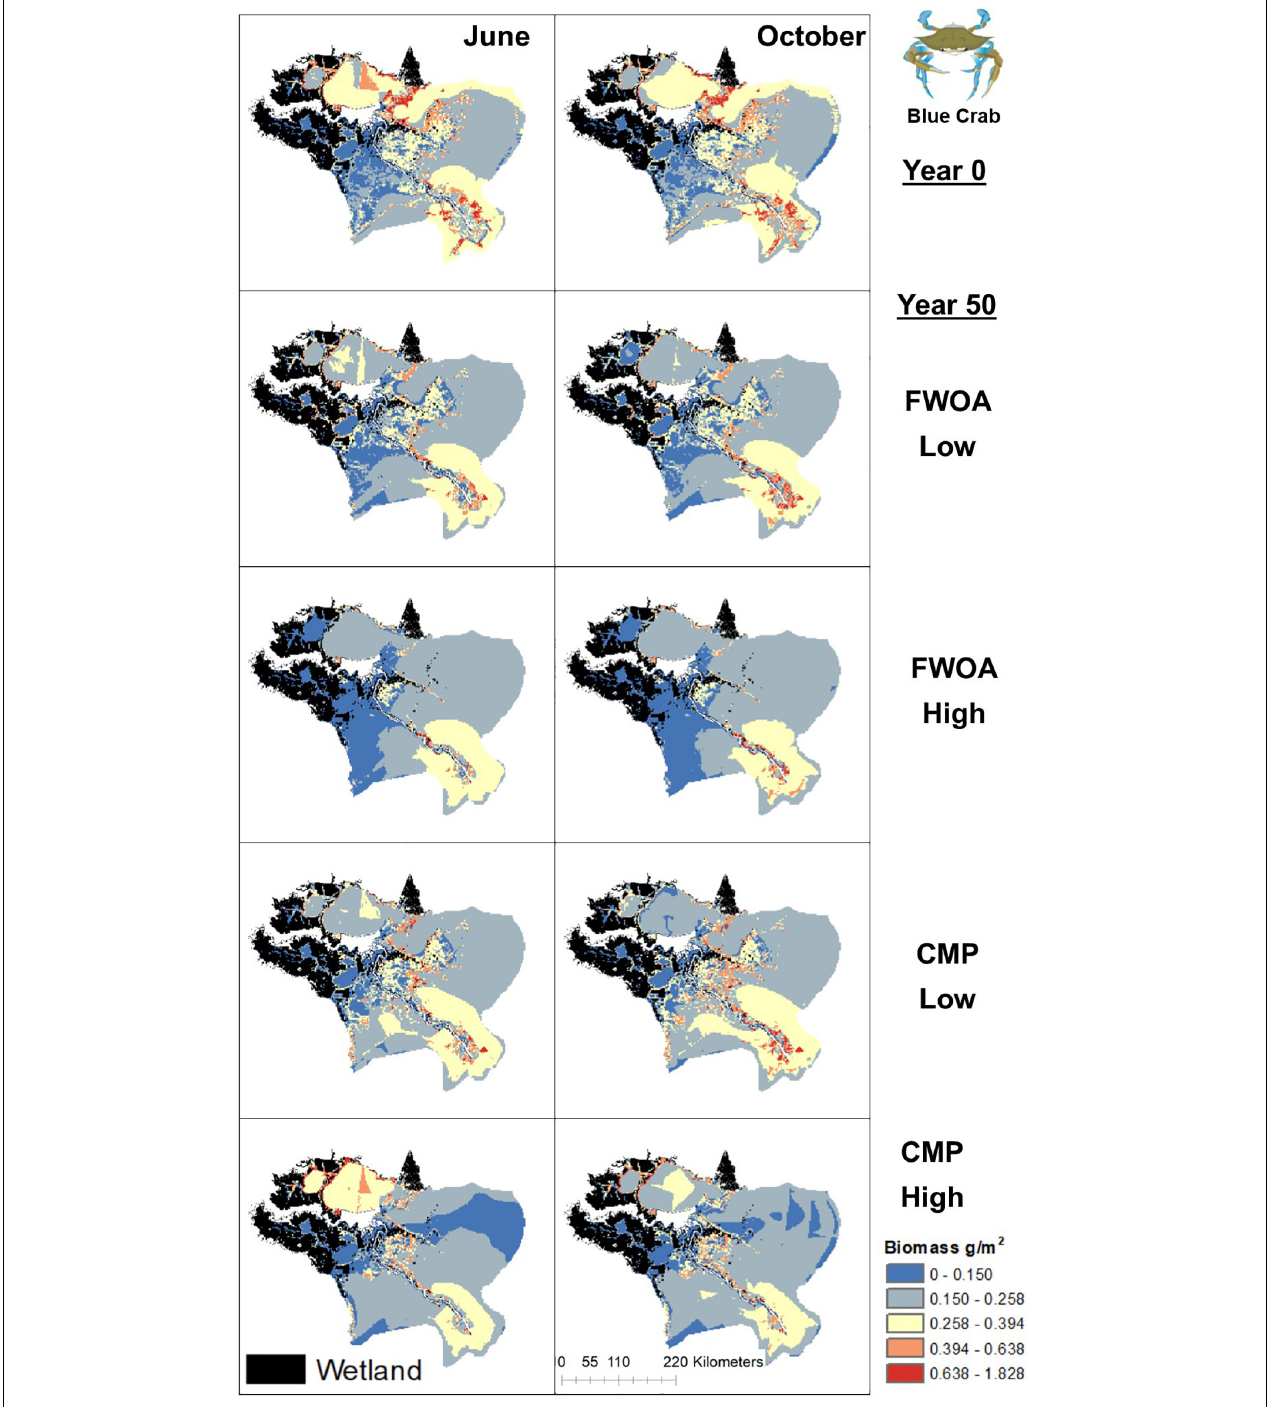
FIGURE 6 | Spatial distribution of juvenile Blue Crab in different simulations. Output is shown from June and October in Year 0 and Year 50, under “Low” and “High” relative sea level rise (see Supplementary Table S6 for scenarios), and with Coastal Master Plan (CMP) implementation and without (FWOA).